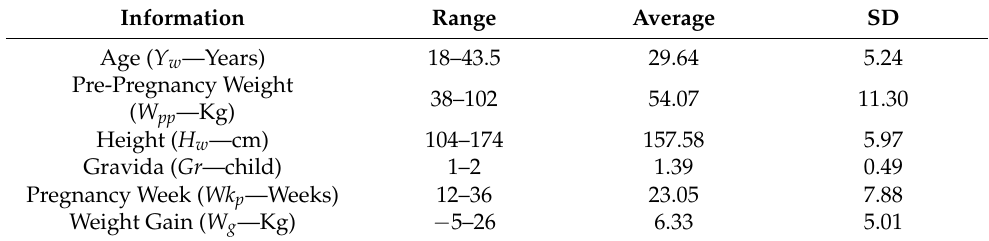
Table 1. Information the pregnant